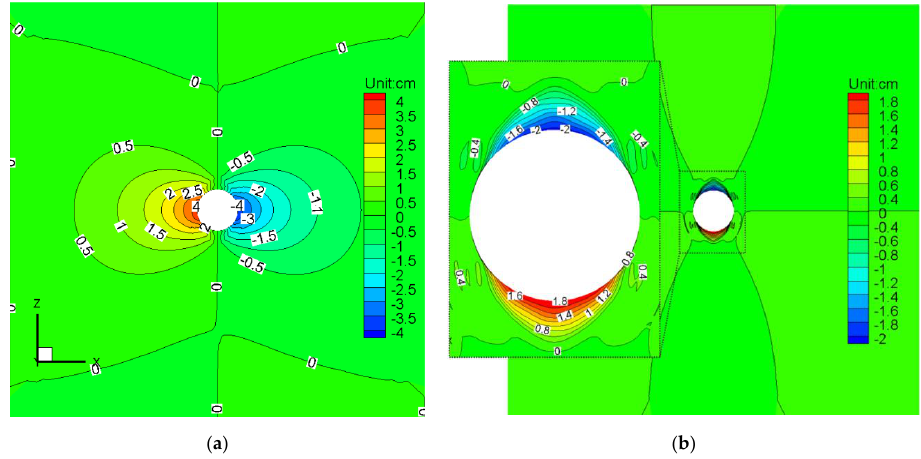
Figure 20. The surrounding rock mass’s displacement under the new support scheme: (a) Horizontal displacement, (b) Vertical displacement.